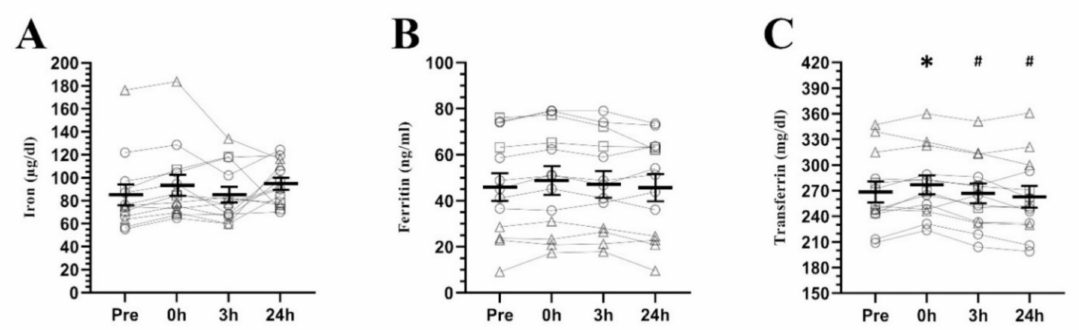
Figure 3. Serum iron ( A ), ferritin ( B ) and transferrin ( C ) concentrations at baseline and its response to a high-intensity interval running session (mean ± SEM). Pre, pre-exercise; 0 h, 0 h post-exercise; 3 h, 3 h post-exercise; 24 h, 24 h post-exercise. * Significantly di ff erent from pre-exercise. # Significantly di ff erent from 0 h post-exercise. Circles = participants with non-depleted ferritin stores ( ≥ 30 ng / mL), Squares = participants with high estrogen concentrations ( > 100 pg / mL) and non-depleted ferritin stores ( ≥ 30 ng / mL), Triangles = participants with depleted ferritin stores ( < 30 ng /